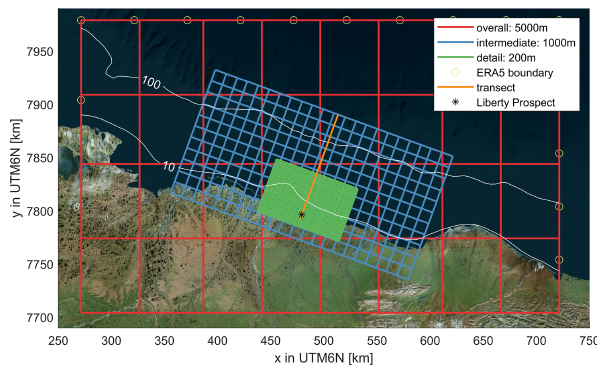
Figure 4. Three-level SWAN model nests with the coarse overall (red), intermediate (blue), and fine detailed grid (green). The model resolution is 10 times denser than depicted in the figure. ERA5 wave boundary points are presented as circles. Black star denotes the lo- cation of the proposed construction of an artificial island in Foggy Island Bay. © Microsoft Bing